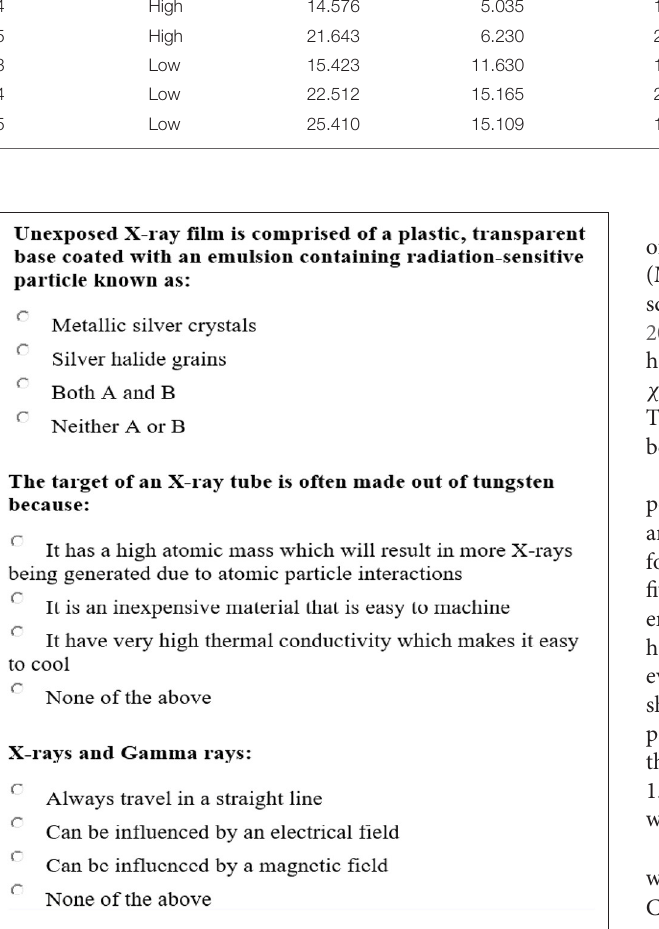
FIGURE 2 | Three sample items of the health profession